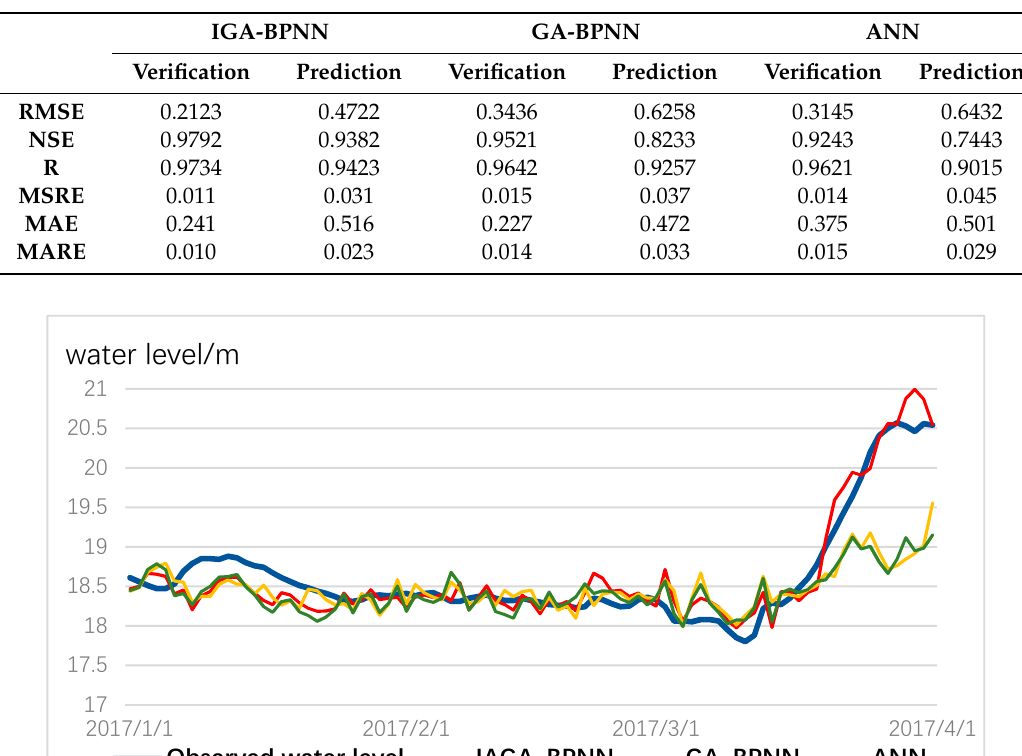
Table 8. Performance indices of water-level prediction models.